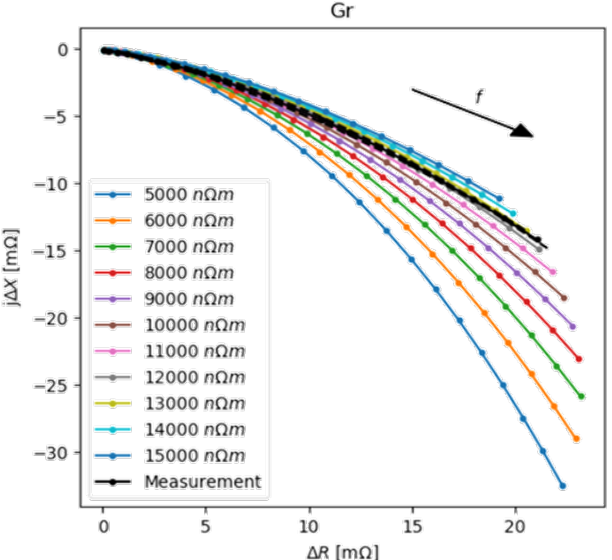
Figure 11. Response of the coil on a graphite substrate of 1.5 mm thickness and h = 0.7 mm lift-off (measured data with dashed lines representing the measurement standard deviation) compared to different simulated responses varying the bulk resistivity between 5000 n Ω m and 15,000 n Ω m.